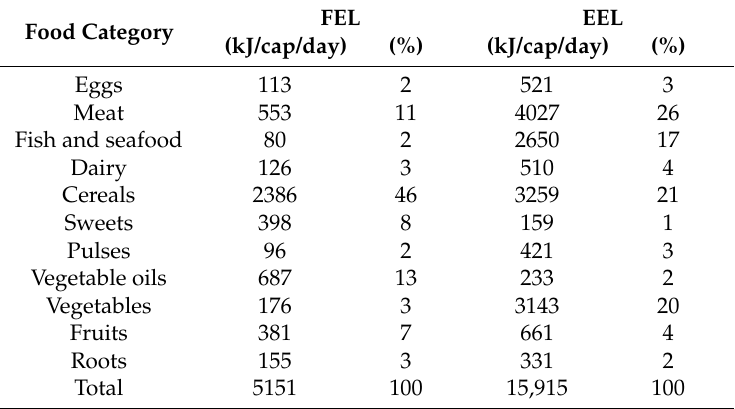
Table 2. Food energy loss and embodied energy loss.